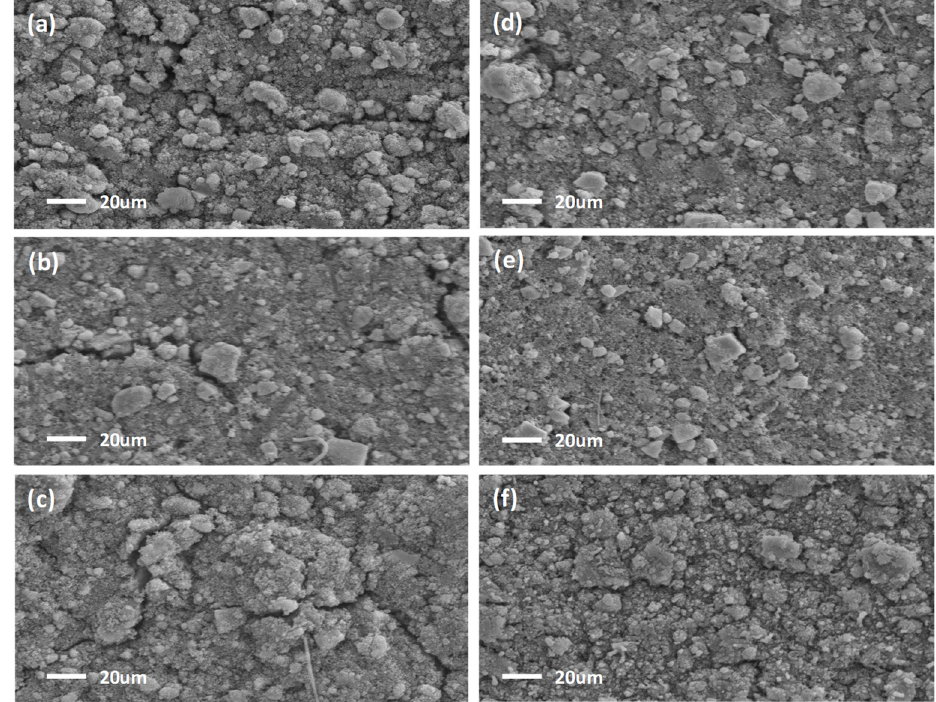
Figure 10. Postmortem SEM images of the ( a , d ) SbTe-C20, ( b , e ) SbTe-C30, and ( c , f ) SbTe-C40 electrodes prepared with (a–c) the PVDF binder and (d–f) the PAA binder after cycling in cells with 5% FEC added to the electrolyte.